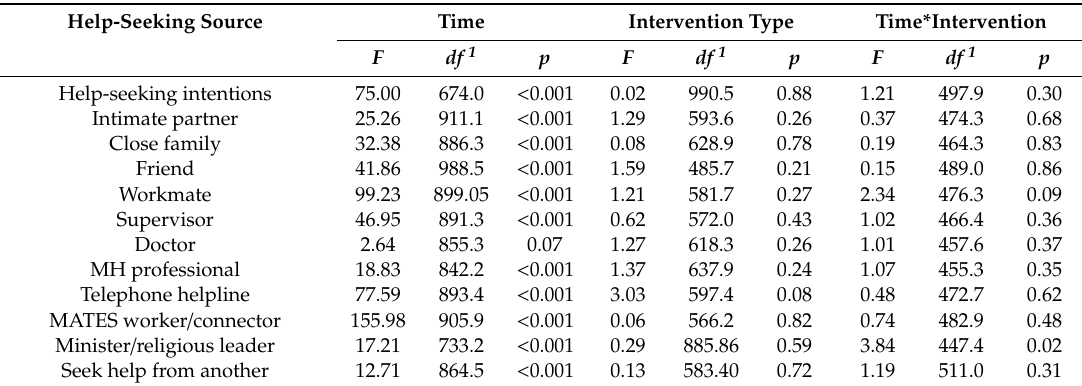
Table 3. Fixed e ff ect estimates for help-seeking intention.